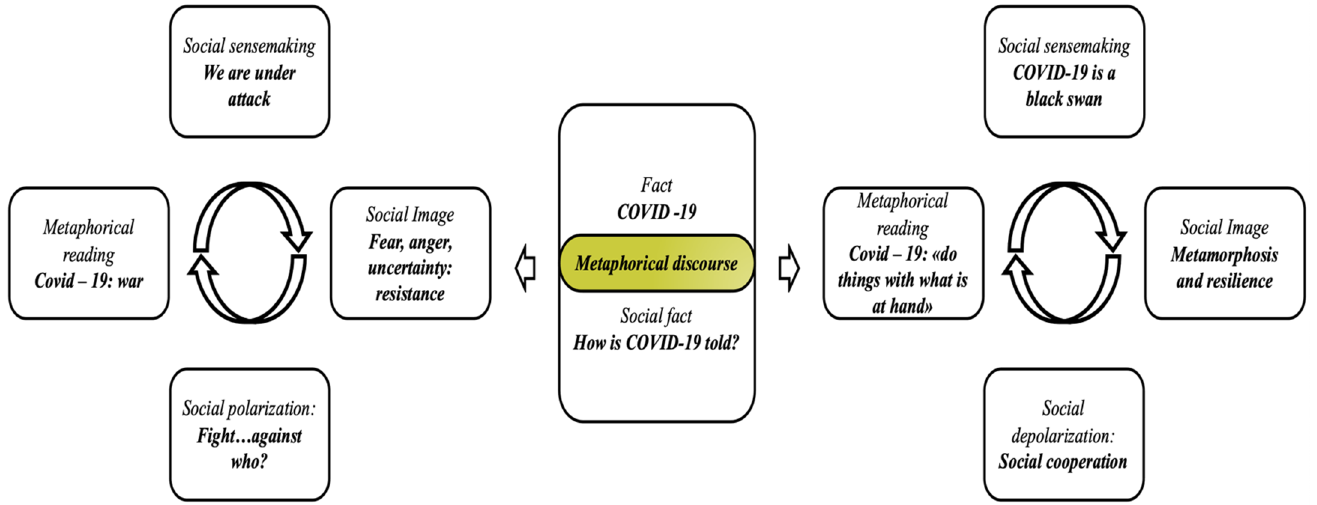
Figure 2. Facts, social facts, and metaphorical discourse: the case of COVID-19. Source: our elaboration.